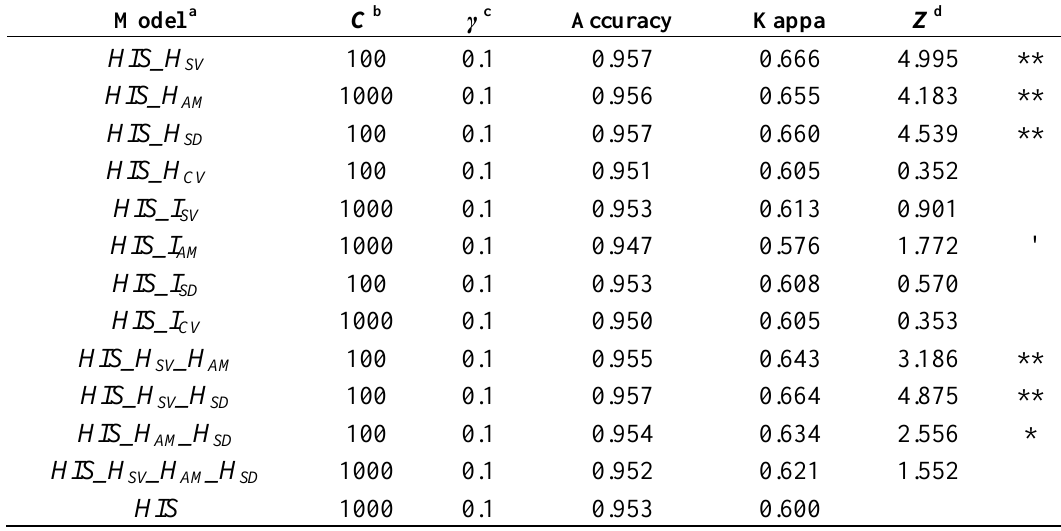
Table 6. Performance of the different models used for classification with